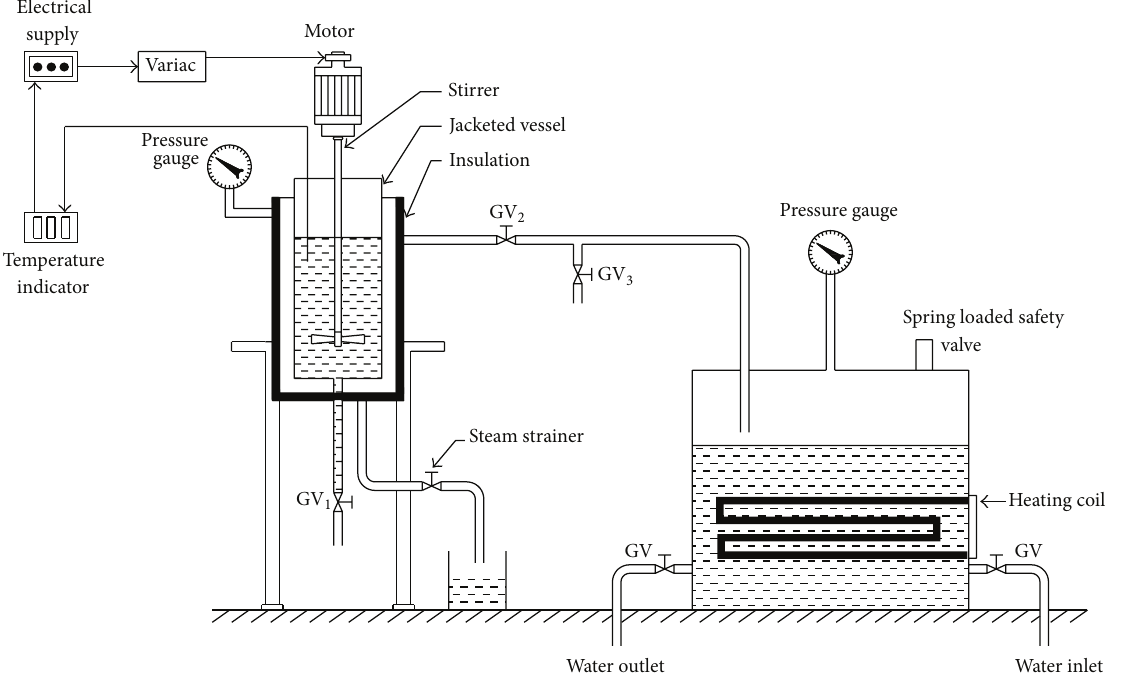
Figure 1: Experimental